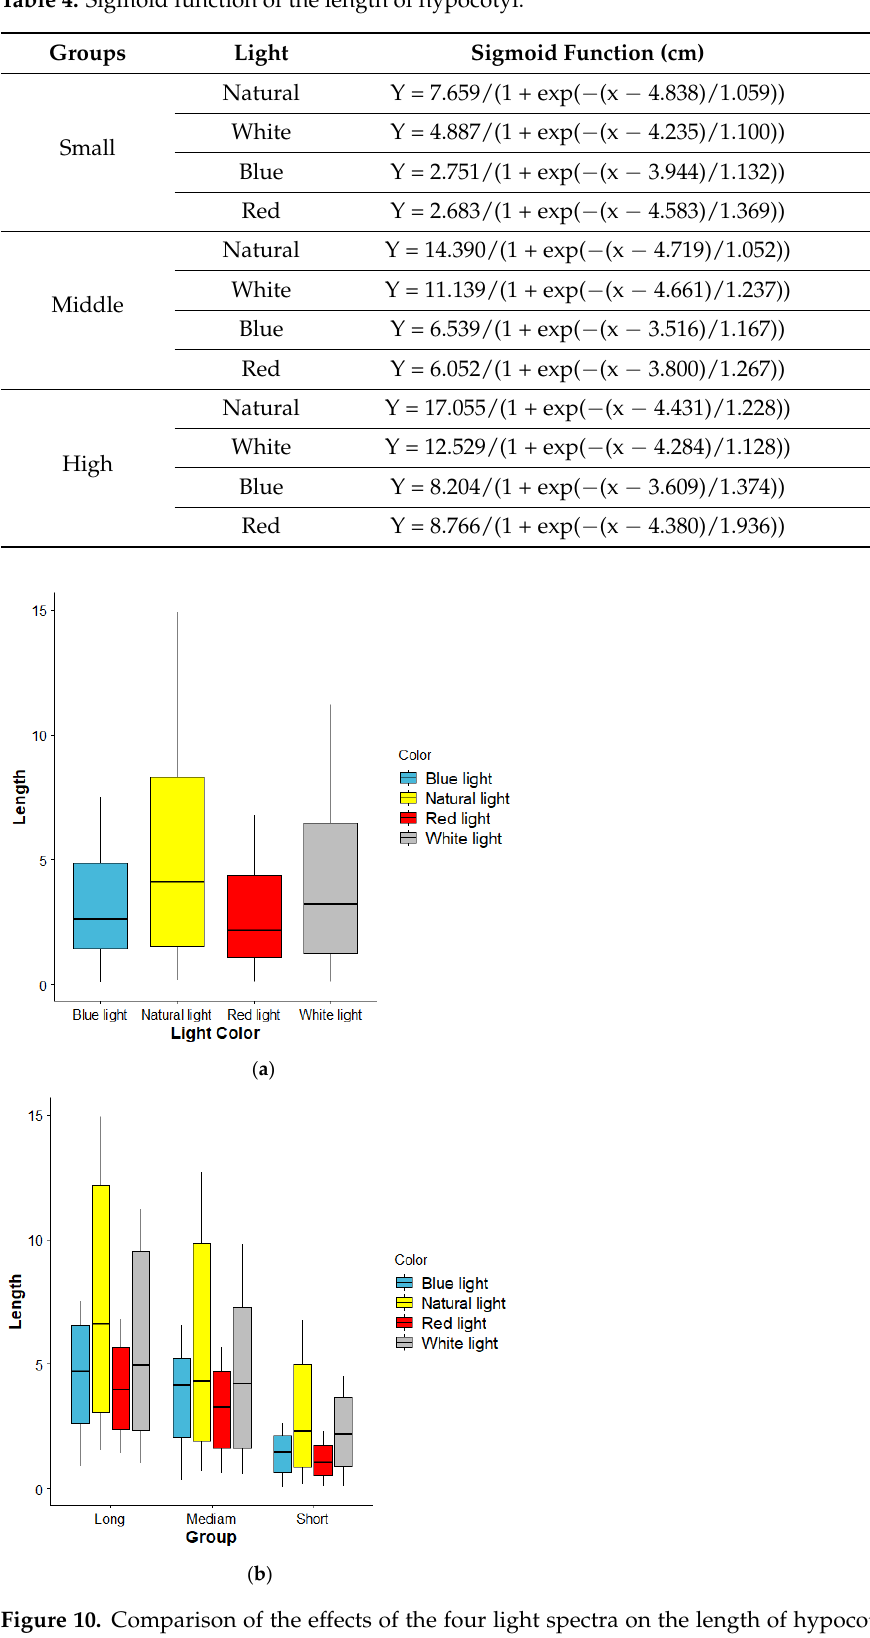
Table 4. Sigmoid function of the length of hypocotyl.